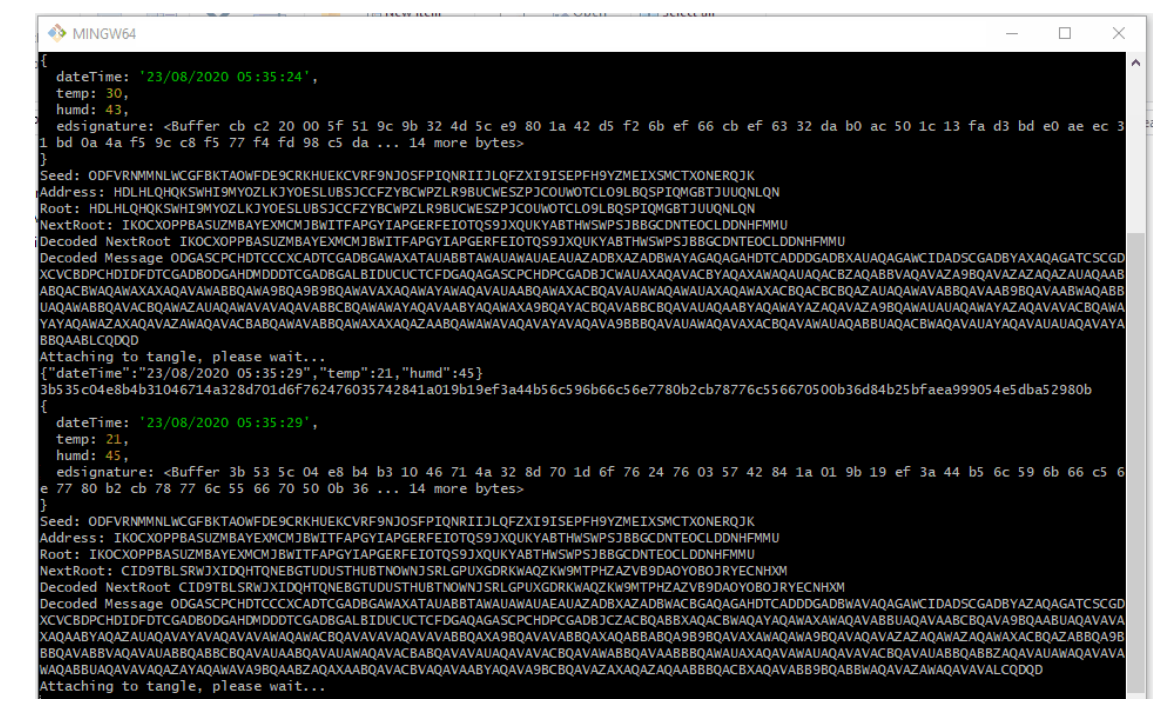
Figure 11. Attaching the rest of the message payload to the Tangle.